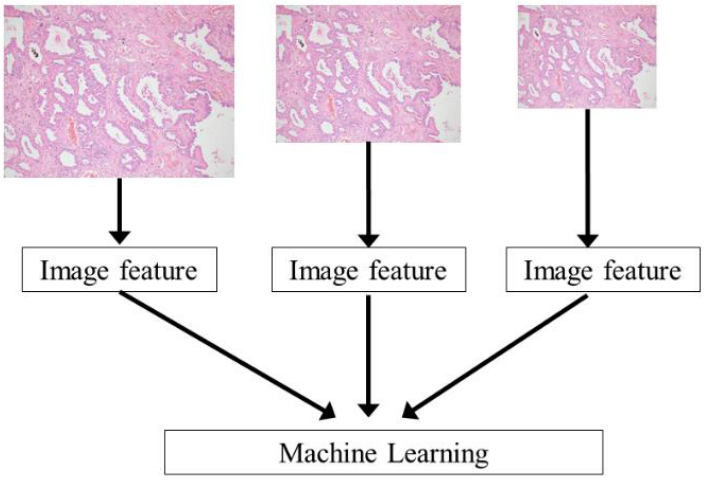
Figure 5. Schematic illustration of the multiscale homology-based image processing.